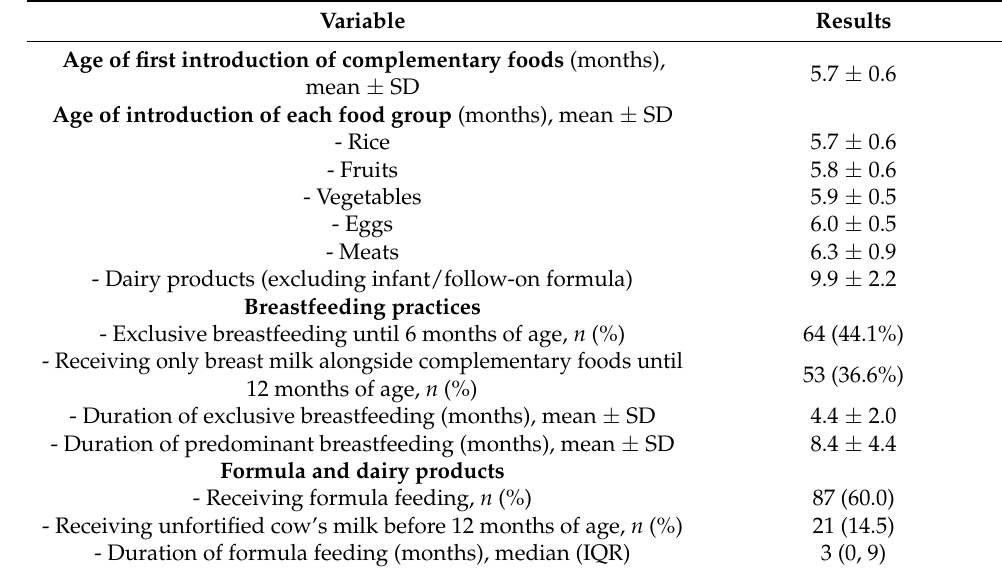
Table 2. Introduction of complementary feeding and milk feeding practices ( n = 145). Variable